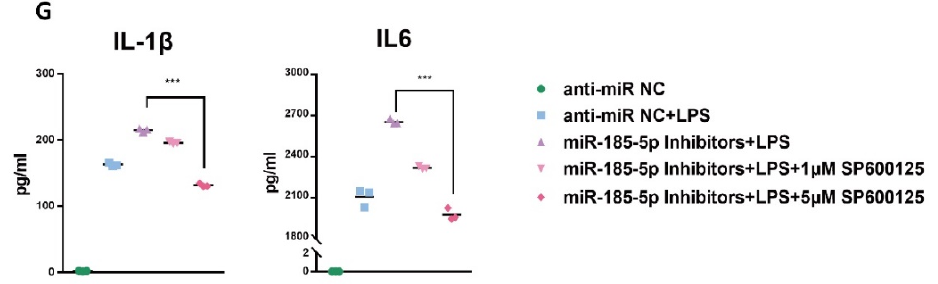
Figure 6. CASIN modulates miR-185-5p-mediated pro-inflammatory phenotype partially through targeting MAPK JNK pathways. ( A ) Gene expressions (RT-qPCR) and ( B ) cytokine secretions (ELISA) in LPS-induced RAW264.7 macrophages with 150 nM miR-185-5p inhibitors or anti-miR NC transfection, 1 µ M CASIN and DMSO treatment. ( C ) Representative images showing phagocytosis of fluorescein-labeled E. coli bioparticles (FITC-Green, DAPI-Blue) in LPS-induced RAW264.7 macrophages with 150 nM miR-185-5p inhibitors or anti-miR NC transfection, 1 µ M CASIN and DMSO treatment. The scale bars correspond to 100 µ m. ( D ) Quantification of mean fluorescence intensity of phagocytosis. ( E ) Effects of CASIN treatment and miR-185-5p knockdown on the activation of the total and phosphorylation of critical proteins in MAPK pathways after treatment with or without 100 ng/mL LPS for 24 h and 1 µ M CASIN or DMSO, as determined by Western blot. ( F ) Quantification of phosphorylation and total proteins in Western blots. ( G ) cytokine secretions (ELISA) in LPS-induced RAW264.7 macrophages with 150 nM miR-185-5p inhibitors or anti-miR NC transfection, 1 µ M, 5 µ M SP600125 and DMSO treatment. Mean ± SD; n = 3; * p < 0.05; ** p < 0.01; *** p < 0.001.